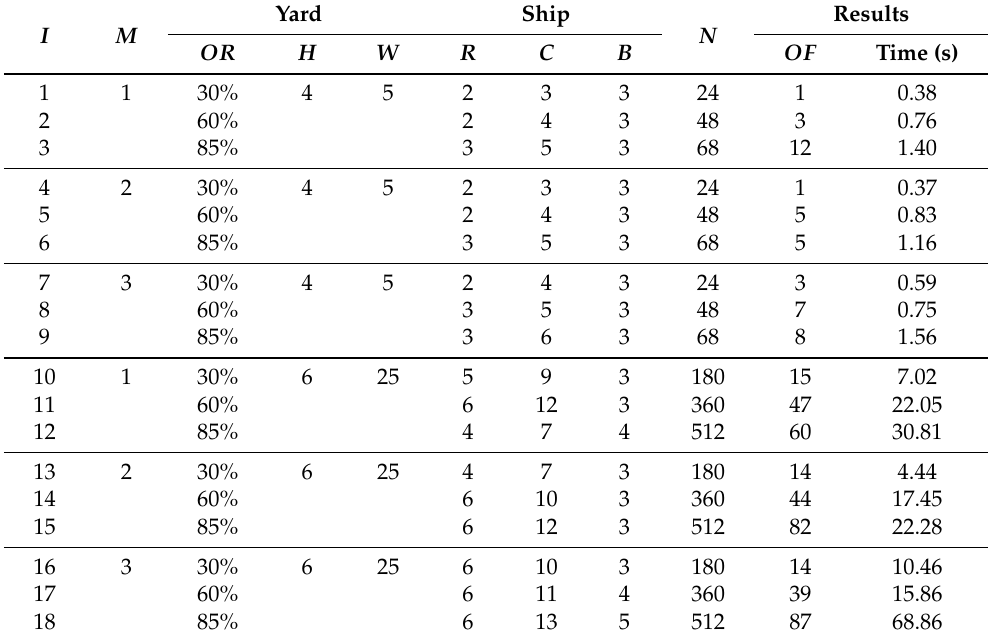
Table 1. Computational results for small- and medium-sized instances for a problem with five ports.